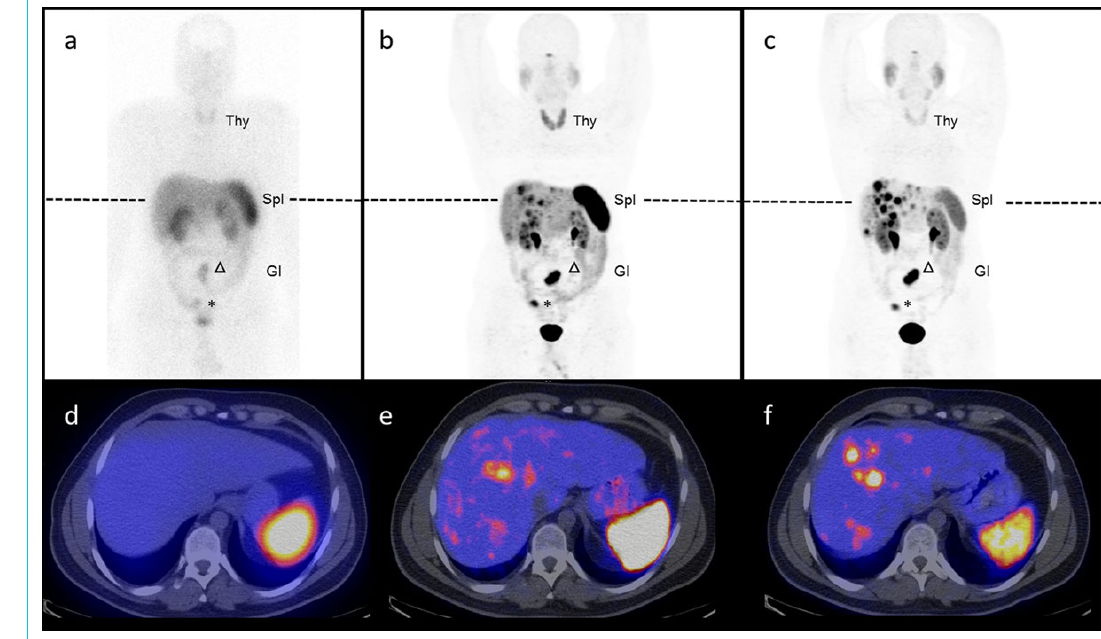
Figure 3: Somatostatin-receptor targeting using 111 In-DTPA-octreotide, 68 Ga-DOTA-octerotide and 68 Ga-DOTA-SSTR-antagonist. Head-to-head comparison of 111 In-DTPA-octreotide scintigraphy and SPECT/CT (a,d) versus 68 Ga-DOTA-TOC PET/CT (b,e), 2 SSTR agonists and 68 Ga-OPS202 PET/CT (c,f), a novel SSTR2 antagonist, in a 32 year-old patient with well differentiated ileal neuroendocrine tumour G2. The primary tumour is in situ (asterisk) and there are a mesenterial lymph (arrow head) and multiple liver metastases. Note, in this otherwise stable disease, the increased number of liver metastases visible on the antagonist scans (c, f) due to an improved signal-to-noise ratio com- pared to the agonist (a and b) as well as the decreased liver, spleen (Spl), thyroid (T) and gastro-intestinal (GI)